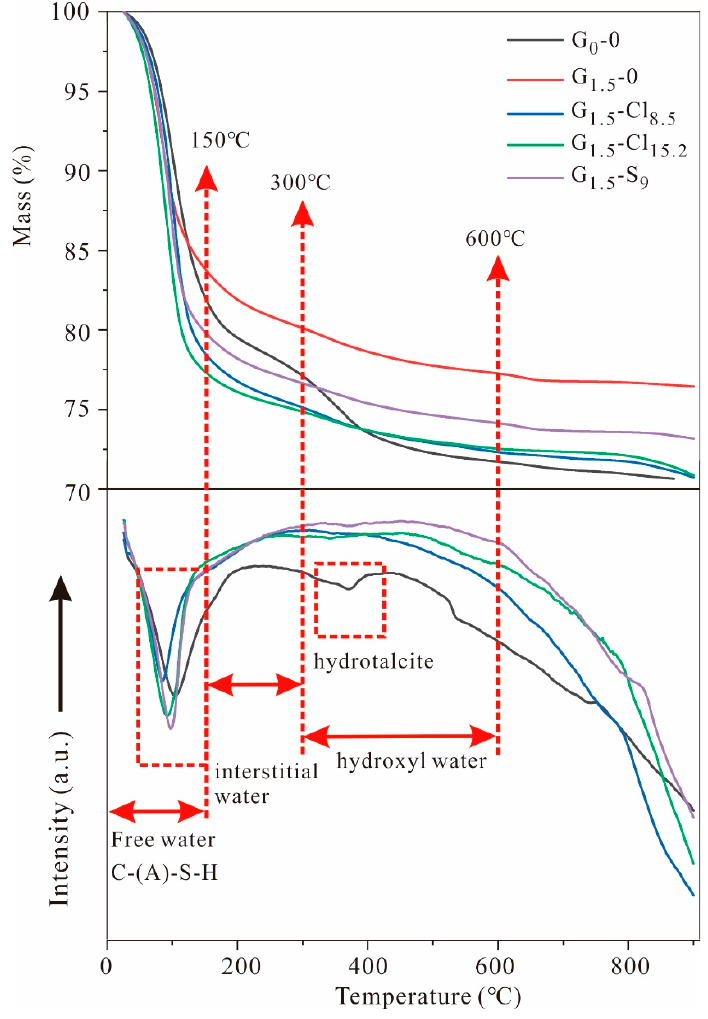
Figure 7. TG and DSC curves of selected geopolymers.